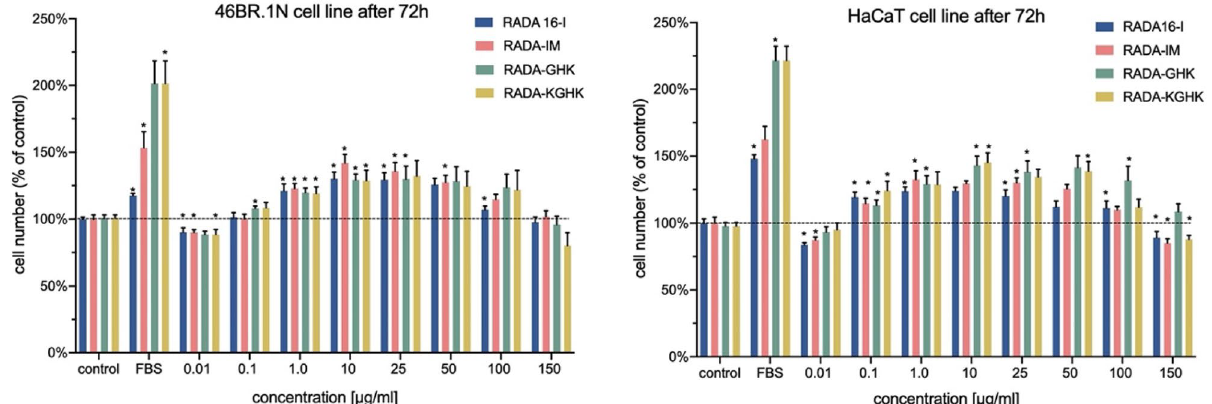
Figure 12. RADA hybrid proliferation test for 46BR.1N fibroblasts and HaCaT keratinocytes after 72 h of incubation. The histogram bars represent results of 3 independent experiments (4 replicates in each, n = 12), and the error bars represent SEM. Statistically significant differences compared to control were determined with the Mann–Whitney U test at p -value < 0.05 and are indicated with an asterisk “*”. FBS—positive control—cells grown in medium containing 10%